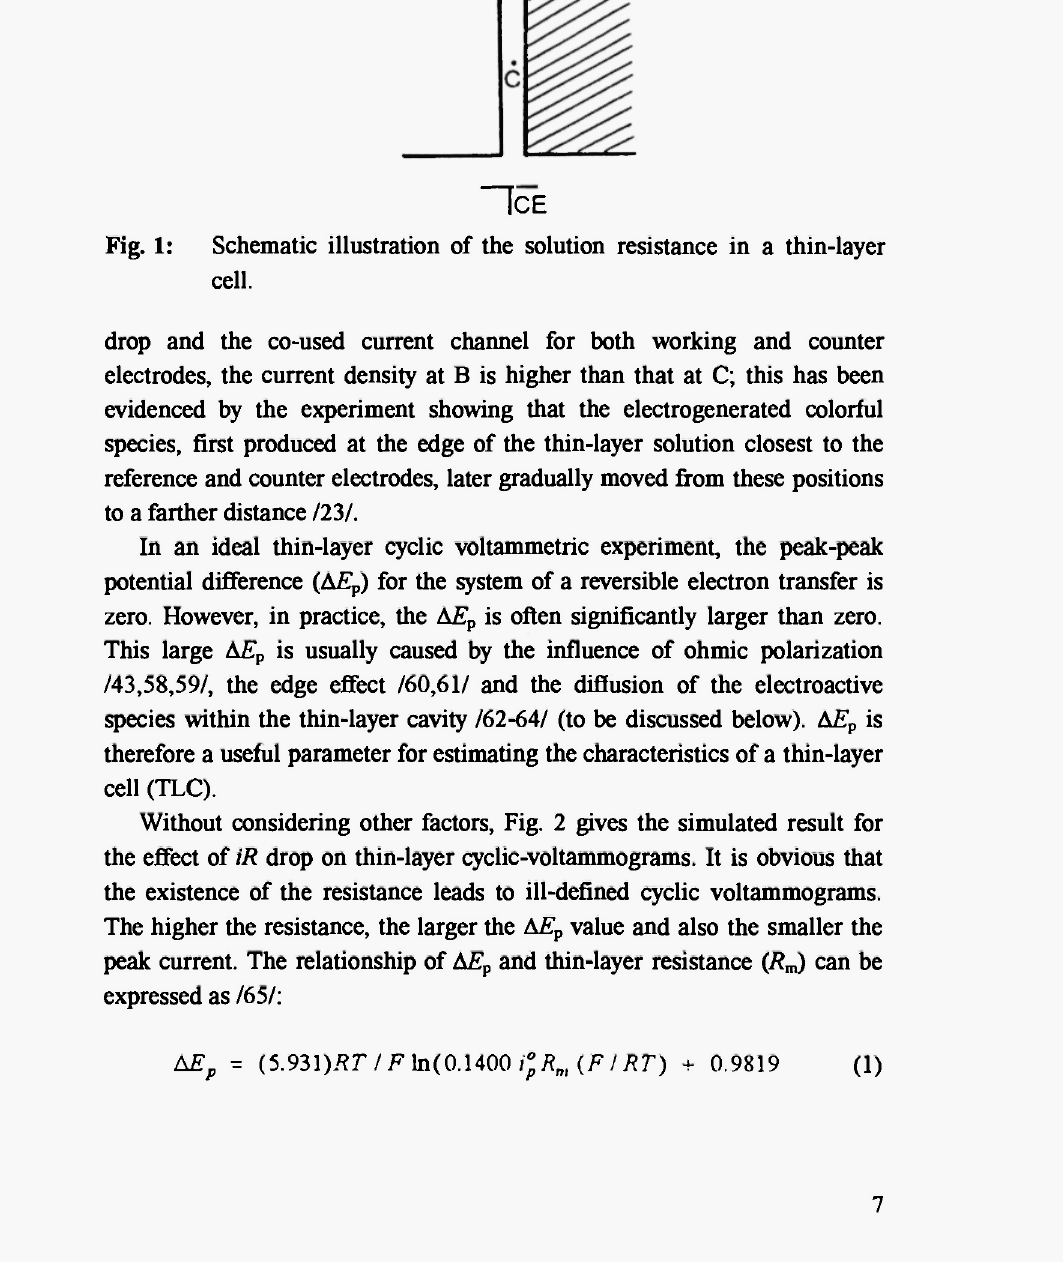
Fig. 1: Schematic illustration of the solution resistance in a thin-layer